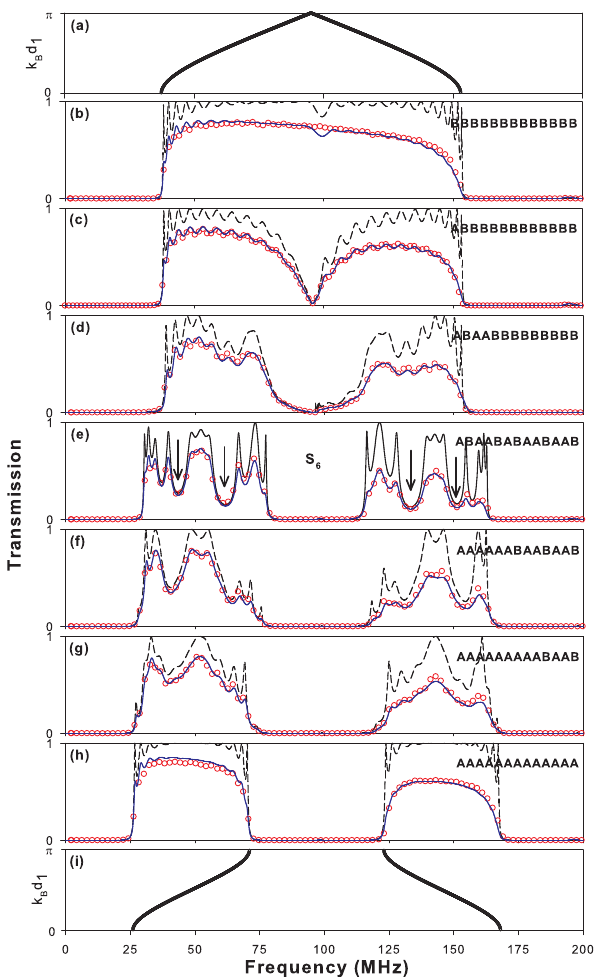
Figure 2. ( a , i ) Dispersion curves of the periodic structures composed of only B or only A blocks respectively. ( b – h ): Variation of the transmittance versus the frequency for different finite structures composed of 13 blocks A and B . ( e ) Transmission spectrum for generation S 6 of the Fibonacci structure. The solid (dashed) curves represent the theoretical results with (without) dissipation, whereas open circles correspond to the experimental